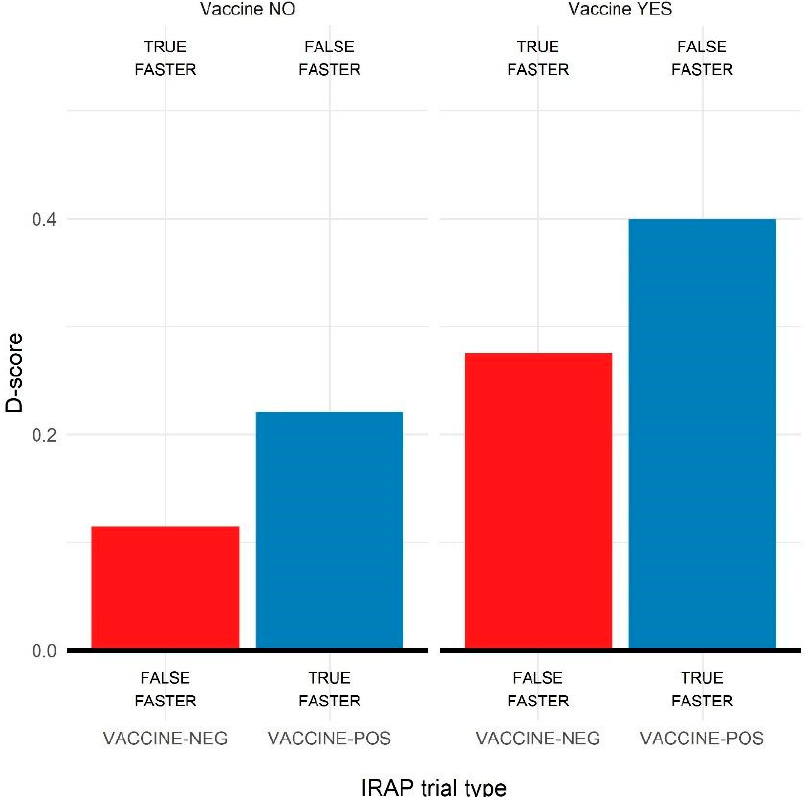
Figure 3. Average D-scores obtained in the four IRAP trial types, with the combination of labels (VACCINE and COVID-19) and targets (POSitive or NEGative), by non-vaccinated ( left panel) and vaccinated ( right panel) participants. The labels at the top or bottom of the plot indicated the direction of the bias according to the consistent (upper) or inconsistent (lower) rules.